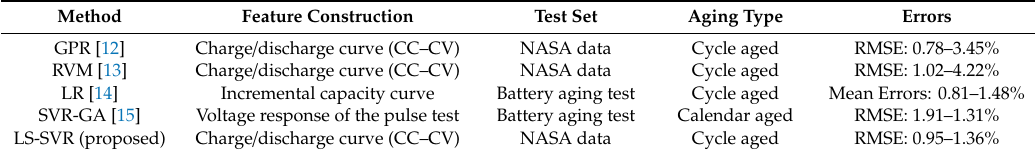
Table 8. Comparison of the proposed method with the start-of-the-art